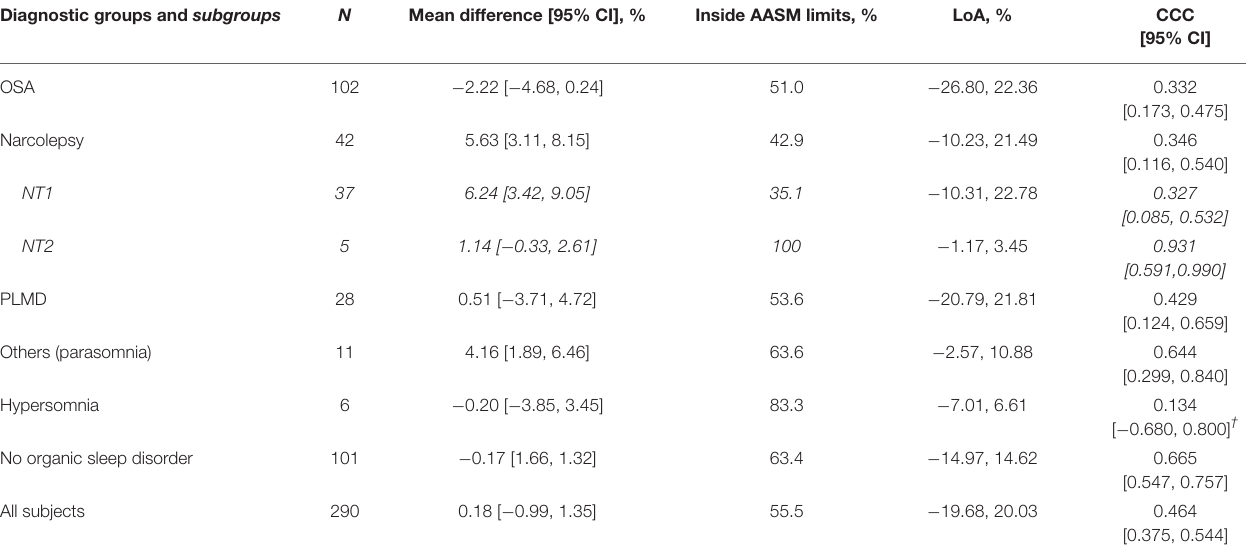
TABLE 3 | Concordance of sleep efficiency between actigraphy and ambulatory polysomnography. Diagnostic groups and subgroups